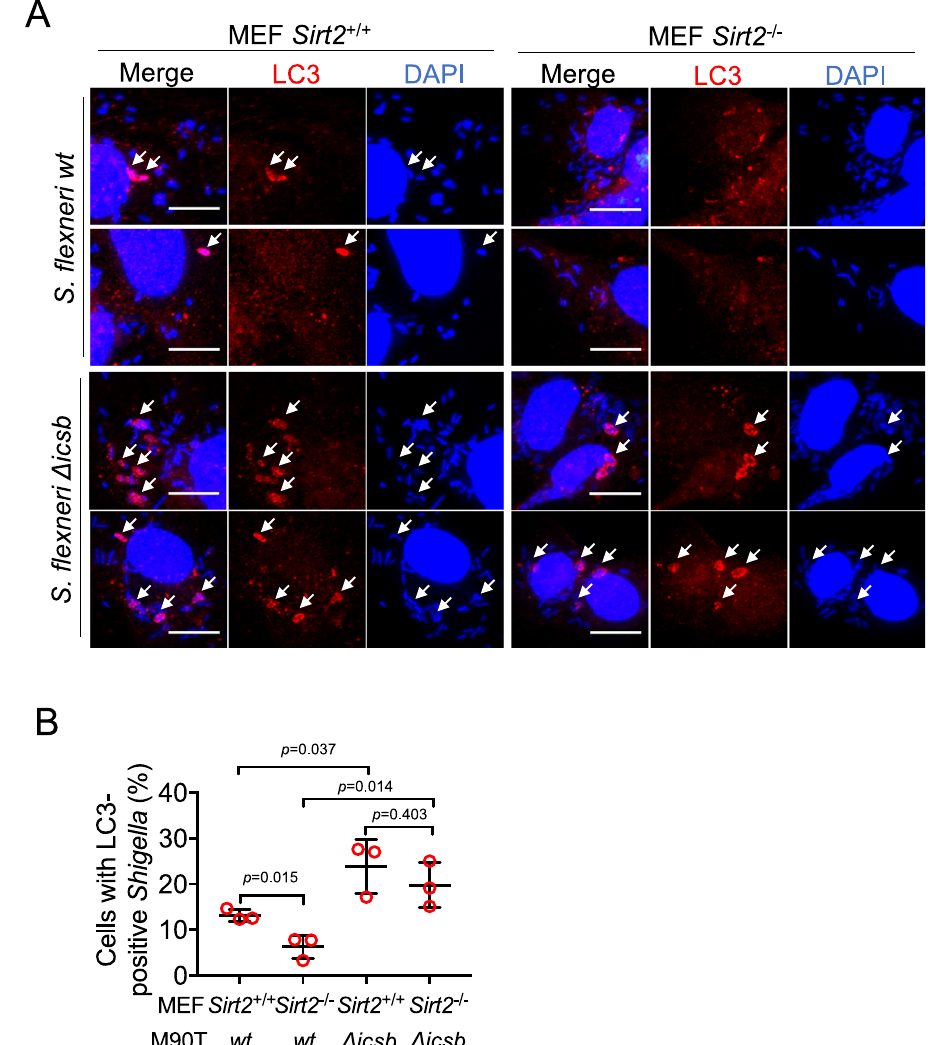
Fig. 6 | SIRT2 suppresses Shigella autophagosome escape. A Effect of SIRT2 knockouton S. fl exneri autophagosomeescape.RepresentativeimagesofMEFcells infectedwith S. fl exneri fromthreebiologicalreplicatesareshown.Scalebar:15 μ m. White arrow: LC3-positive Shigella . B Quantitation of data shown in A . Percentage